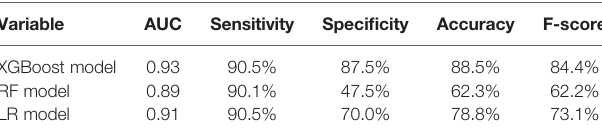
anti-in fl ammatory cytokine by suppressing macrophage and Dendritic Cells (DCs), thereby limiting T helper 1 (Th1) and T helper 2 (Th2) effector responses (Couper et al., 2008).